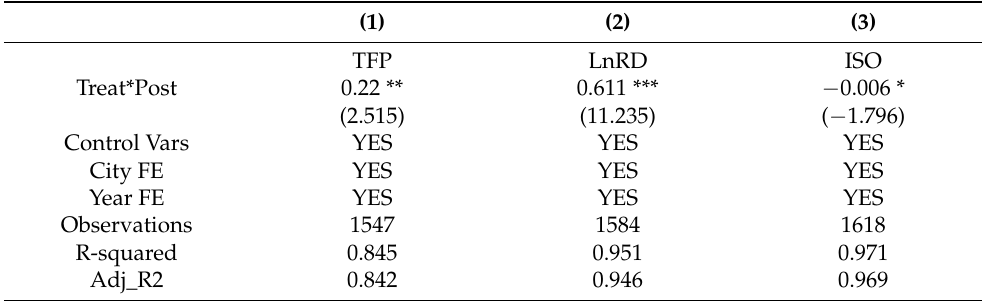
Table 6. Mechanism analysis of the effect of city cluster policy on CO 2